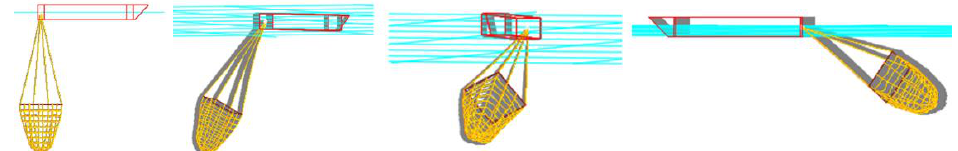
Figure 29. Shape changes of rigid truss trawl in rotating towing under fixed angular velocity at v =